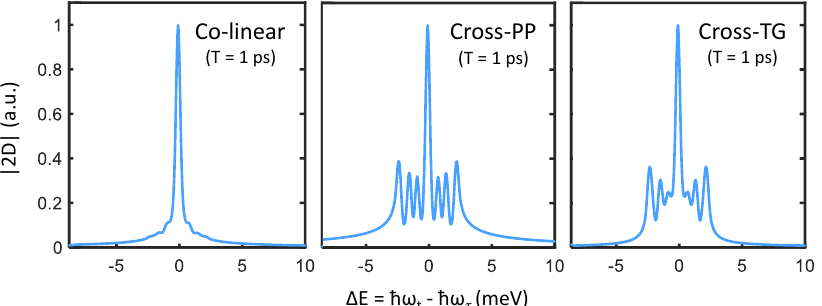
Figure 5. Cross-diagonal slices centered at | ¯ h ω t | = | ¯ h ω τ | = 2590 meV from the three one-quantum spectra plotted in Figure 4. Signatures of the triplet-state fine-structure manifest in the cross-PP and cross-TG slices, while being suppressed in the colinear